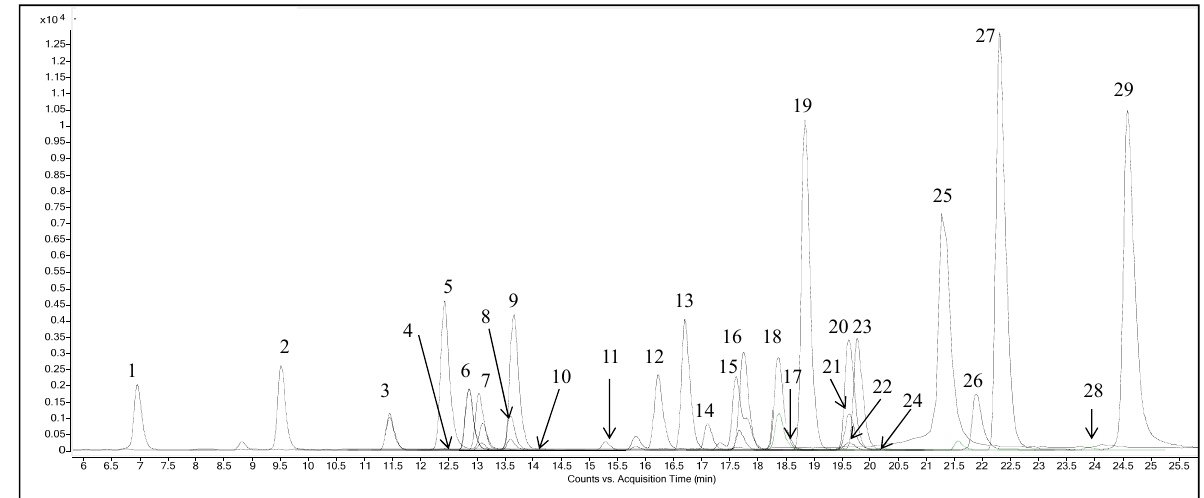
Figure 1. Standard mixture HPLC-MS/MS chromatogram plotted as overlapped transition of each standard in multiple reaction monitoring mode. (1) Gallic acid, (2) neochlorogenic acid, (3) (+)-catechin, (4) procyanidin B2, (5) chlorogenic acid, (6) p -hydroxybenzoic acid, (7) ( − )-epicatechin, (8) 3-hydroxybenzoic acid, (9) caffeic acid, (10) vanillic acid, (11) syringic acid, (12) procyanidin A2, (13) p -coumaric acid, (14) ferulic acid, (15) 3,5-dicaffeoylquinic acid, (16) rutin, (17) hyperoside, (18) isoquercitrin, (19) phloridzin, (20) quercitrin, (21) myricetin, (22) naringin, (23) kaempferol-3-glucoside, (24) hesperidin, (25) ellagic acid, (26) quercetin, (27) phloretin, (28) kaempferol, (29) isorhamnetin. Although the total polyphenol contents (TPC) have been evaluated for a broad spectrum of nuts, data regarding the individual phenolic compounds of nuts are still scarce [20]. In the present work, HPLC-MS/MS was used to quantify 29 phenolic compounds in the extracts of fresh, boiled, roasted (oven or microwave), and fried chestnut seeds. Considering the sum of the analyzed compounds, the TPCs were 165.35, 258.18, 103.27, 271.78, and 192.22 mg/kg DW in the raw, boiled, microwave-roasted, oven- roasted, and fried seeds, respectively. TPCs in seeds were increased by all treatments except for microwave roasting; the highest TPC was observed in oven-roasted seeds (271.78 mg/kg) followed by boiled seeds (258.18 mg/kg), and the lowest TPC was detected